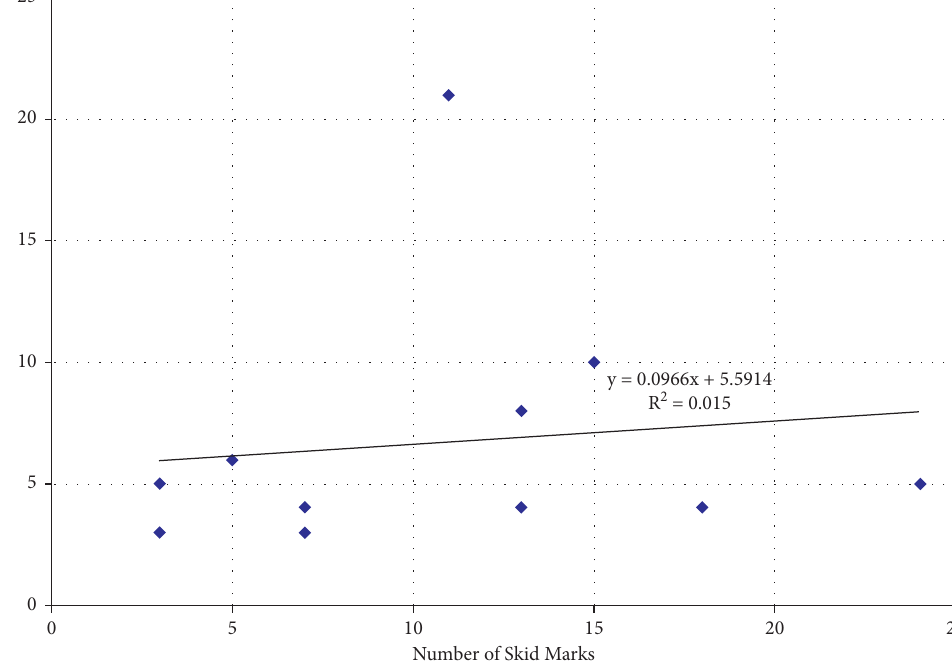
Figure 10: Rear-end crash vs. skid correlation by 1-mile segments on Interstate 80 westbound.